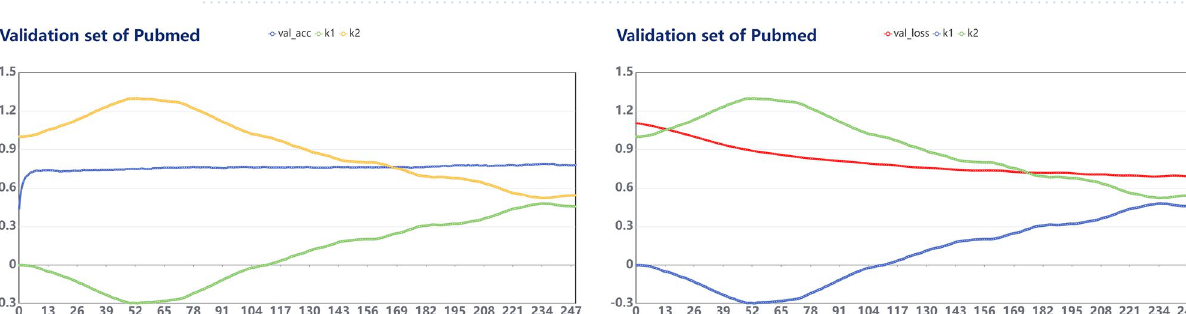
Figure 10. Pubmed: Fitting relationship between train_acc, train_loss and parameters.